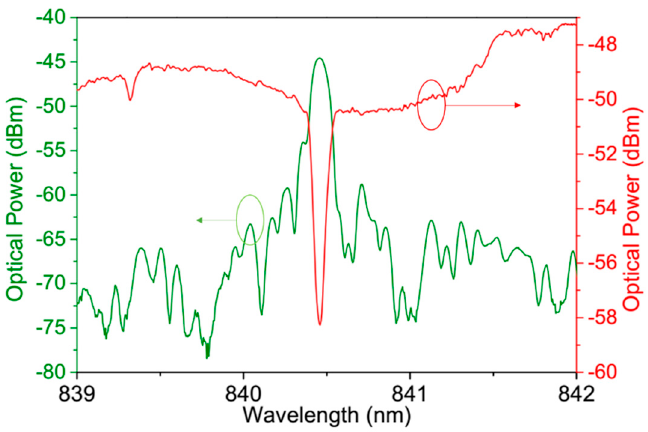
Figure 2. Transmission and reflection spectrum of Fiber Bragg Grating in BDK-doped micro-structured polymer optical fiber (mPOF) with one single 266 nm wavelength pulse; image adapted from [103].